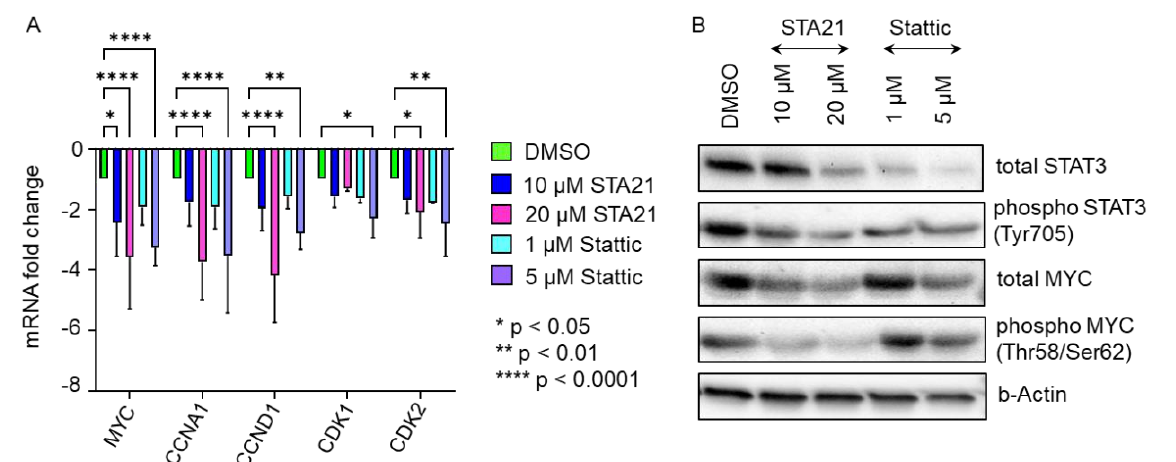
Figure 6. Cell cycle gene expression was significantly reduced in the presence of STAT3-specific inhibitors STA21 and Stattic. ( A ) mRNA expression levels of MYC, CCNA1, CCND1, CDK1 and CDK2 , which are pivotal for cell cycle progression and cell proliferation, were reduced after treatment with STAT3 specific inhibitors STA21- (blue, magenta) or Stattic- (cyan, violet) in BM-derived stromal cells. Treatment with the compound as indicated was carried out for 8 h and mRNA expression levels were compared to DMSO-treated BM-derived stromal cells (green). Data shown are mean mRNA fold change values of three biological replicates measured in technical duplicate. ( B ) Western blot analysis demonstrates substantially reduced protein expression of STAT3 and MYC in HPL-cultivated BM-derived stromal cells after STAT3-inhibitor treatment.